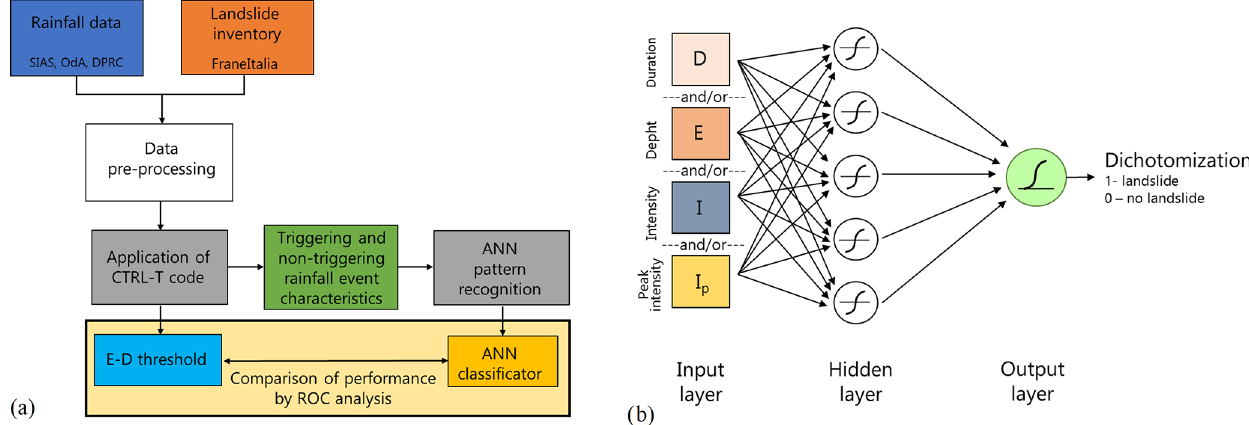
Figure 2. Flow chart illustrating the methodology (a) and the artificial neural network architecture considered (b) .